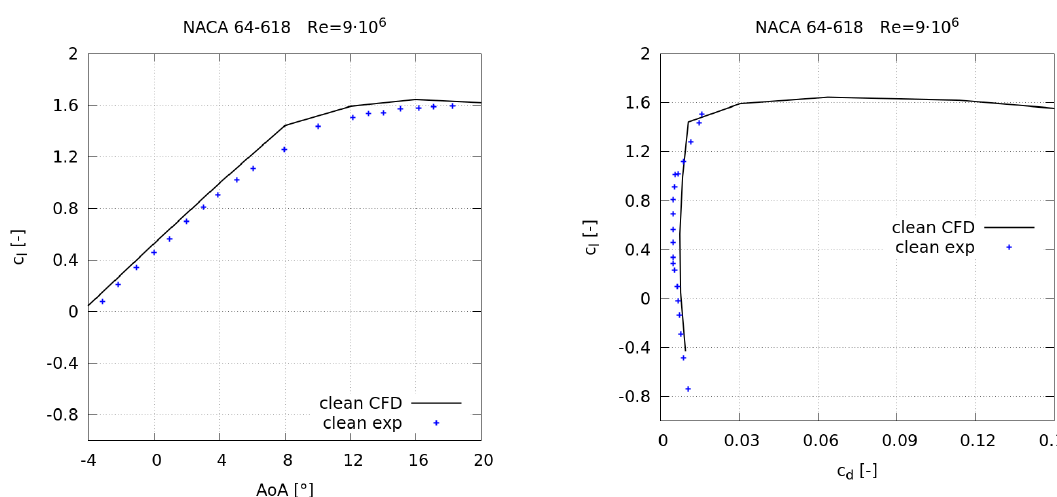
Figure 5. Validation of numerical results by CFD against wind tunnel measurements of a NACA 64-618 at Re = 9 × 10 6 (“clean CFD” refers to resolved boundary layer with transition